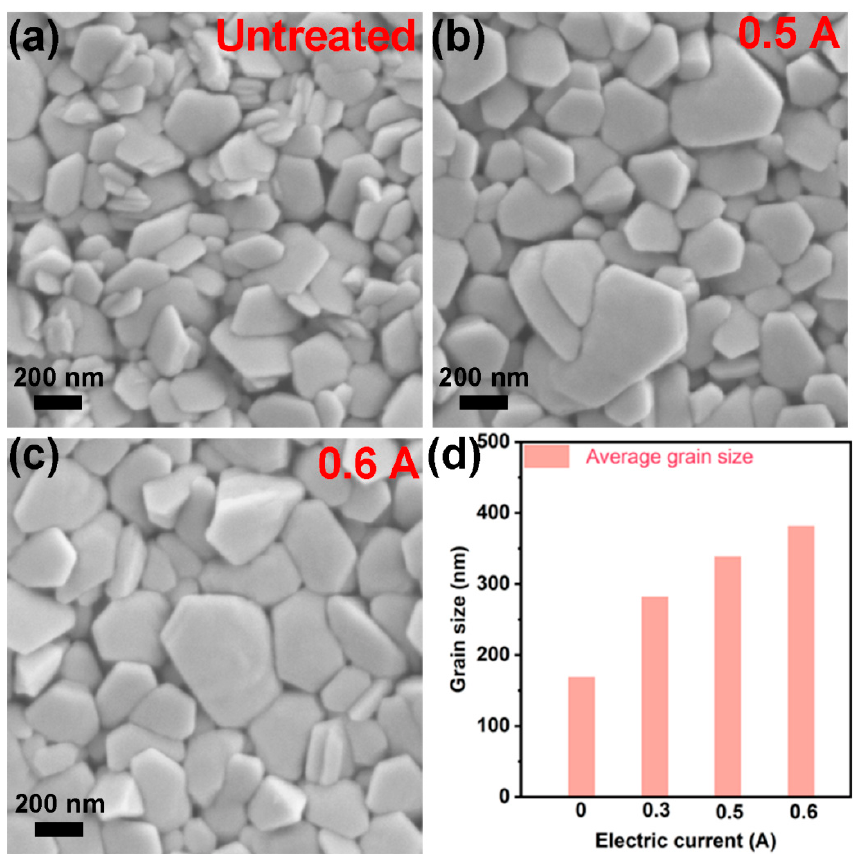
Figure 3. The SEM images of ( a ) untreated Bi 2 Te 3 f-TF; ( b ) 0.5 A-Bi 2 Te 3 f-TF; ( c ) 0.6 A-Bi 2 Te 3 f-TF. ( d ) The average grain size of Bi 2 Te 3 f-TF.